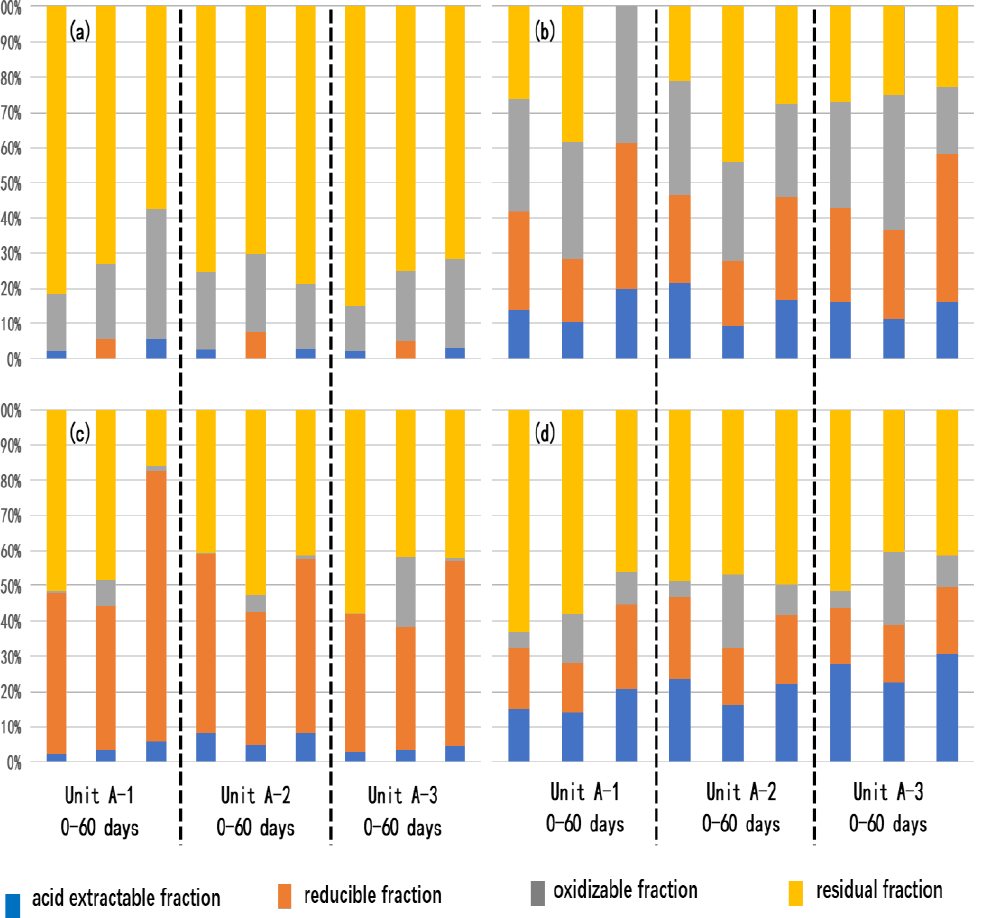
Figure 6. Effect of biochar-stabilization after 30 and 60 days: ( a ) the fraction distribution of As after 0 days, 30 days and 60 days; ( b ) the fraction distribution of Cu after 0 days, 30 days, and 60 days; ( c ) the fraction distribution of Pb after 0 days, 30 days and 60 days; and ( d ) the fraction distribution of Zn after 0 days, 30 days, and 60days.